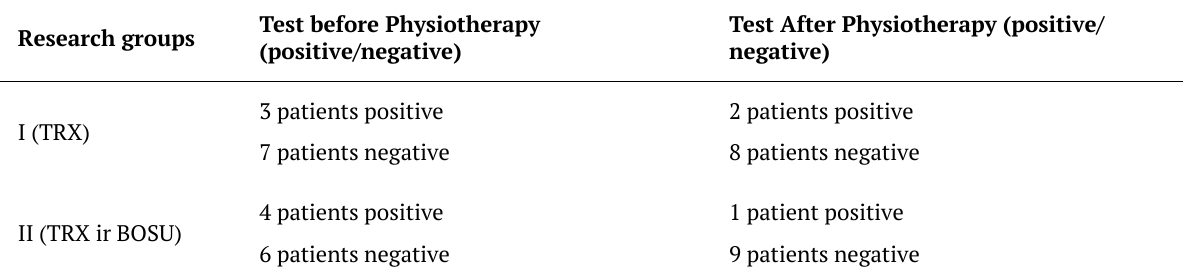
Table 1. Knee joint stability